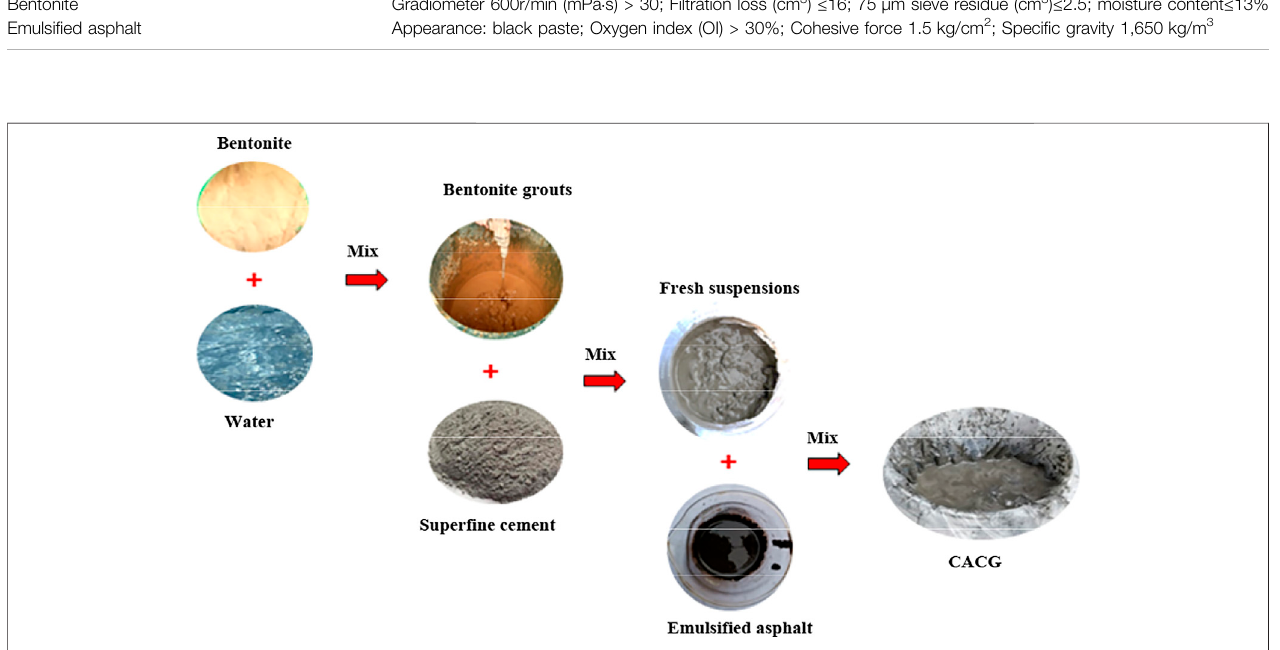
TABLE 1 | Some properties of the raw materials. Ingredient Index Super fi ne cement